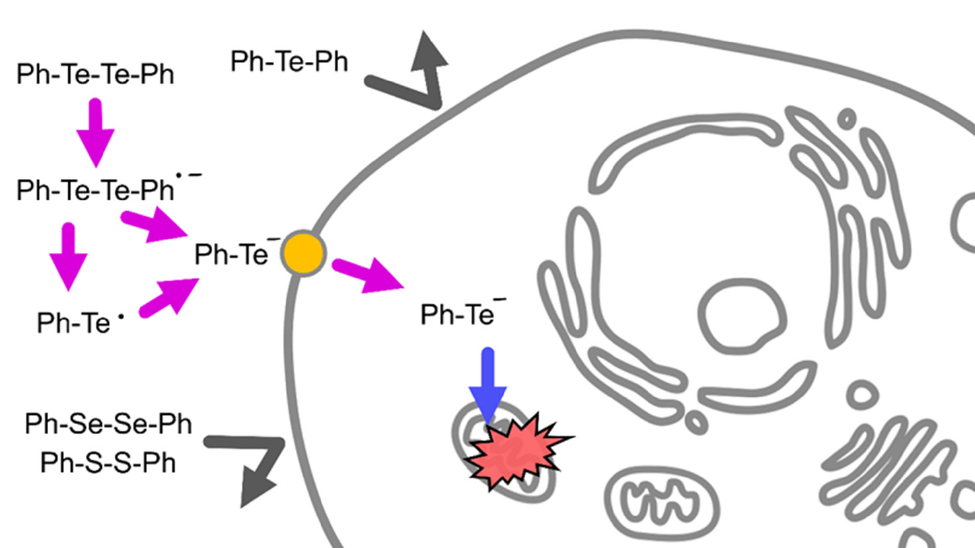
Figure 5. Summary of this study. DPDTe acquires electrons and forms radical anionic molecules. Heterolytic cleavage of the Te–Te bond occurs and produces PhTe − . PhTe − is taken up through cell-type dependent mechanisms and translocated to mitochondria. Accumulated PhTe − in the mitochondria induces cell dysfunction and cytotoxicity.